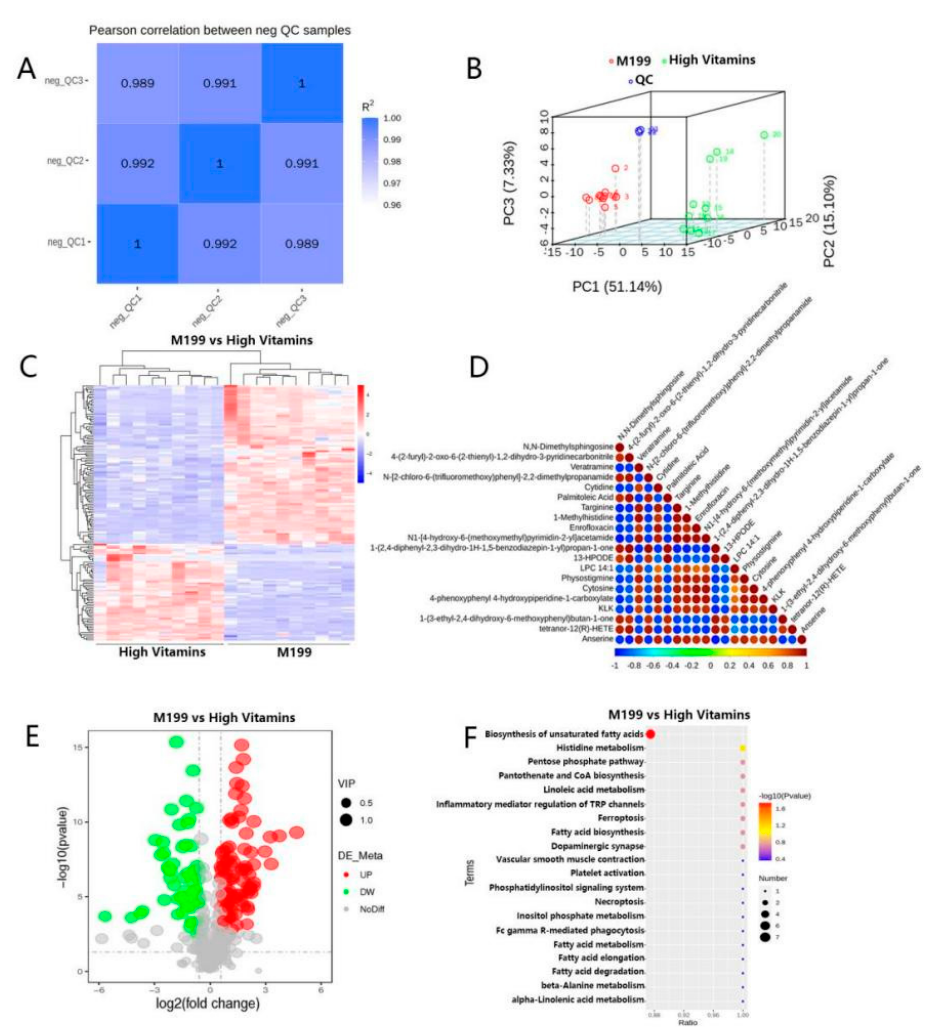
Figure 4. Metabolomics analysis. ( A ) QC sample correlation. The abscissa and ordinate are the QC samples, and the closer the value of R2 is to 1, the better the correlation. ( B ) PCA analysis. The abscissa PC1 and the ordinate PC2 represent the scores of the first and second principal components, respectively, and the scattered points in different colors represent samples from different experimental groups. ( C ) Total differential metabolite-cluster heat map. Hierarchical clustering analysis was performed on the differential metabolites between each comparison pair, and the relative quantitative values of the differential metabolites were normalized, transformed and clustered. The horizontal is the clustering of metabolites, and the vertical is the sample grouping. ( D ) Plot of differential metabolite correlation analysis. By calculating the Pearson correlation coefficient between all the differential metabolites and selecting the top 20 differential metabolites with the significance level p -value sorted from small to large for display, you can check the consistency of the metabolite and metabolite change trends. ( E ) Sample comparison versus volcano plot. The volcano plot is drawn according to the VIP value, p -value and FC value of the differential metabolites between the comparison pairs, which can visually display the overall distribution of the differential metabolites. ( F ) KEGG-enrichment bubble map: according to the KEGG enrichment results, select the top 20 pathways with p -values from small to large to draw a bubble map. The abscissa is x/y (the number of differential metabolites in the corresponding metabolic pathway/the total number of metabolites identified in the pathway); the larger the value, the higher the enrichment of differential metabolites in the pathway. The ordinate is the KEGG pathway